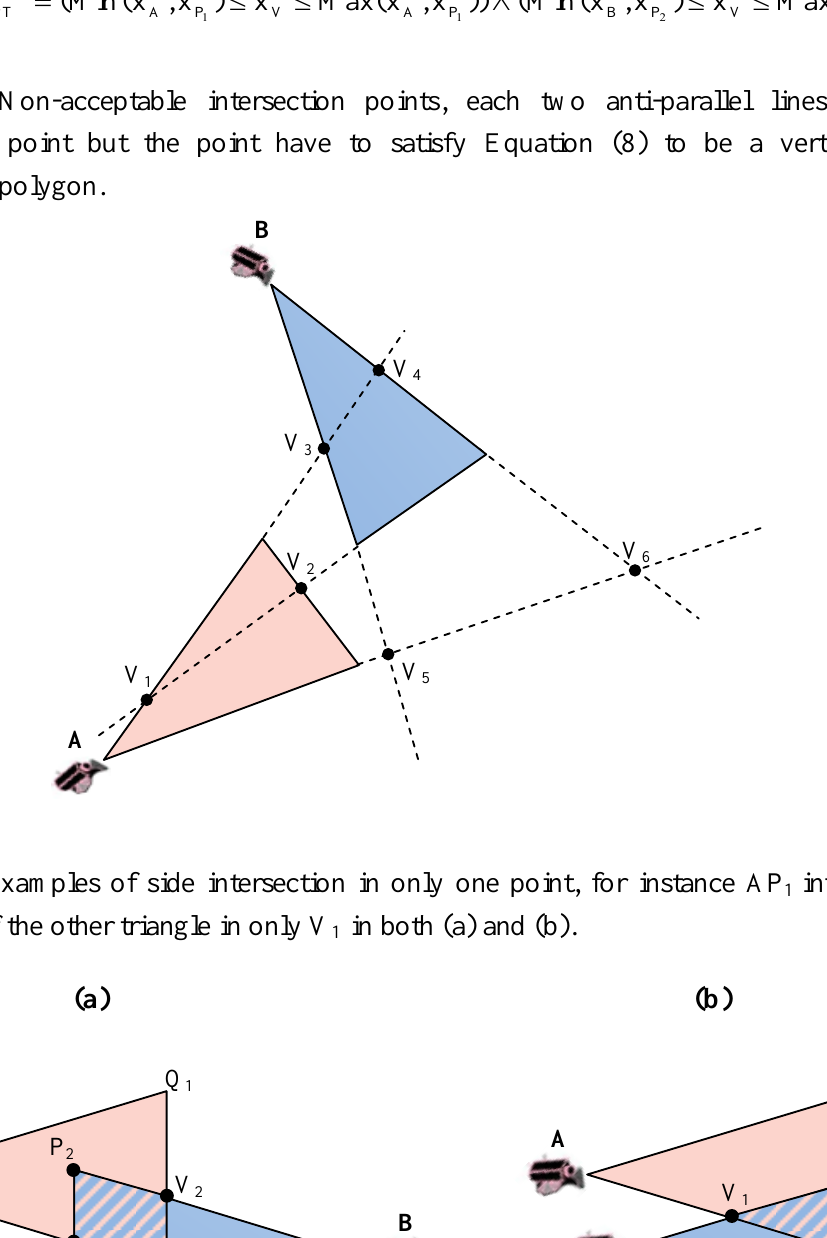
in both (a) and 1